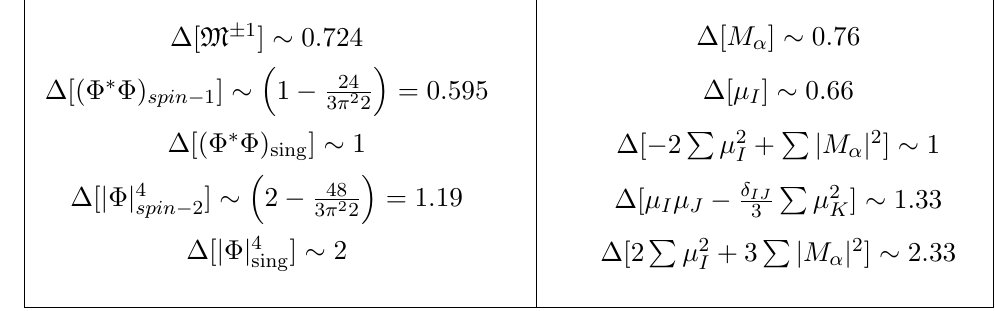
Table 15 . Operator mapping across the duality and the scaling dimensions of the